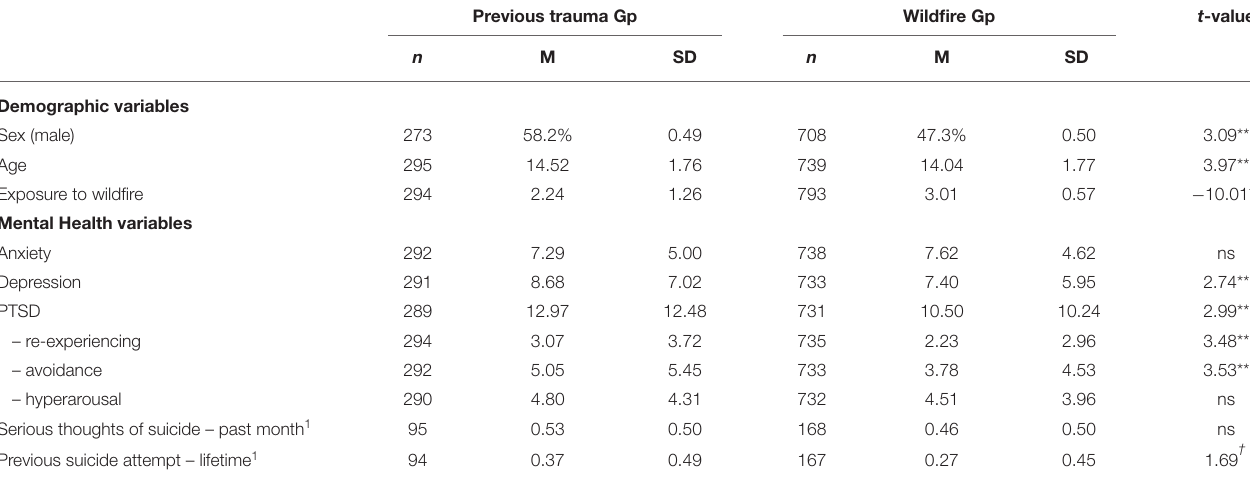
M, mean; SD, standard deviation. † 0.05 > p <